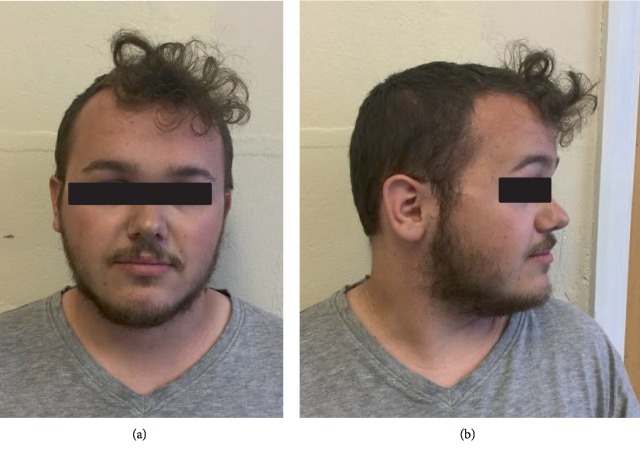
(a and b) B1 (aged 21 years) facial front view and profile. Note prominent forehead and high anterior hairline.